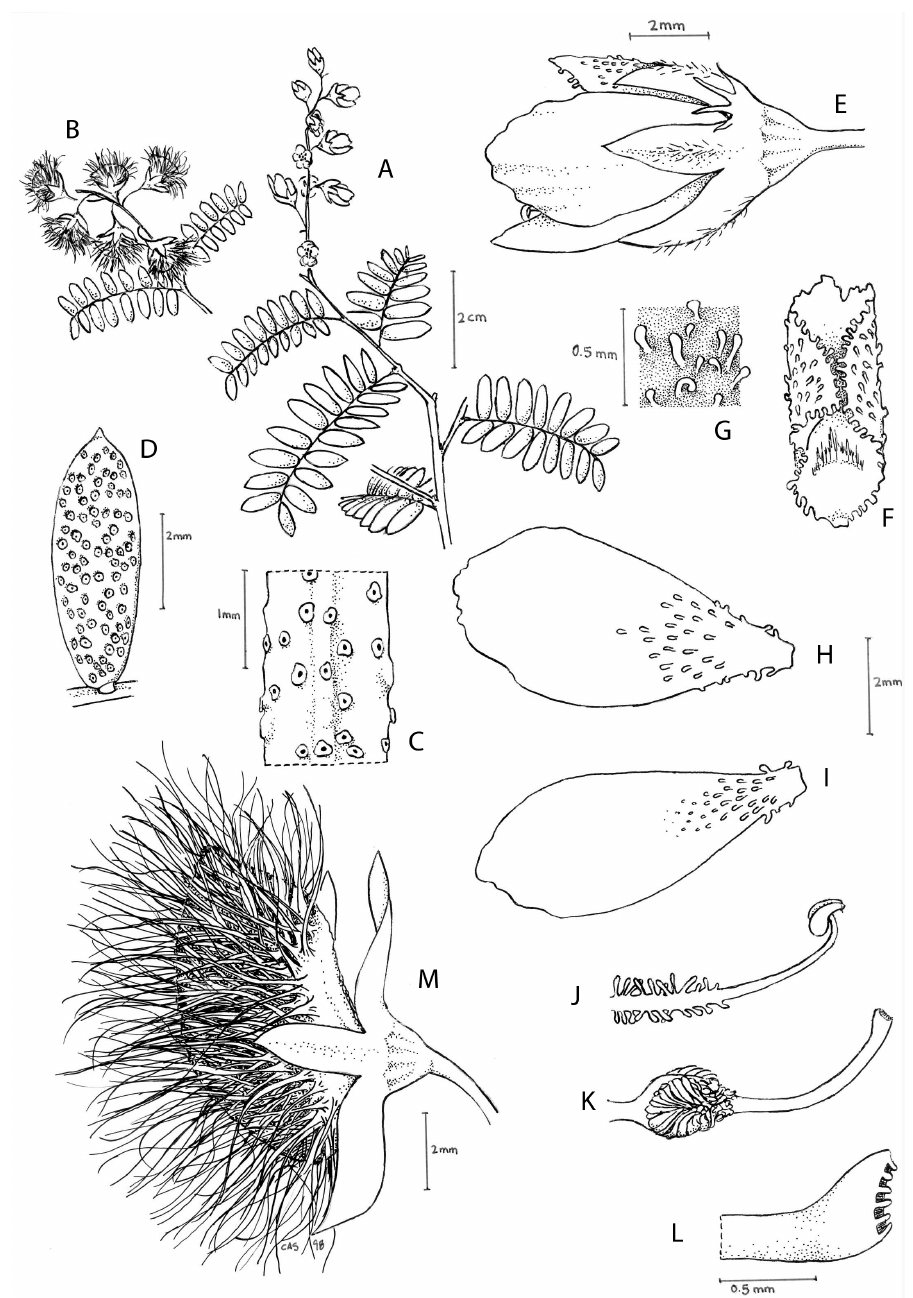
Fig 35. Zuccagnia punctata Cav.. A flowering branchlet B infructescence C stem section D leaflet E flower (unopened) F median petal G detail of petal glands H upper lateral petal I lower lateral petal J stamen K gynoecium L stigma M fruit. A, D from Tinto 2017 B, M from Wingenroth et al. 354 C, E–L from Cabrera 30149. Drawn by Christi A.